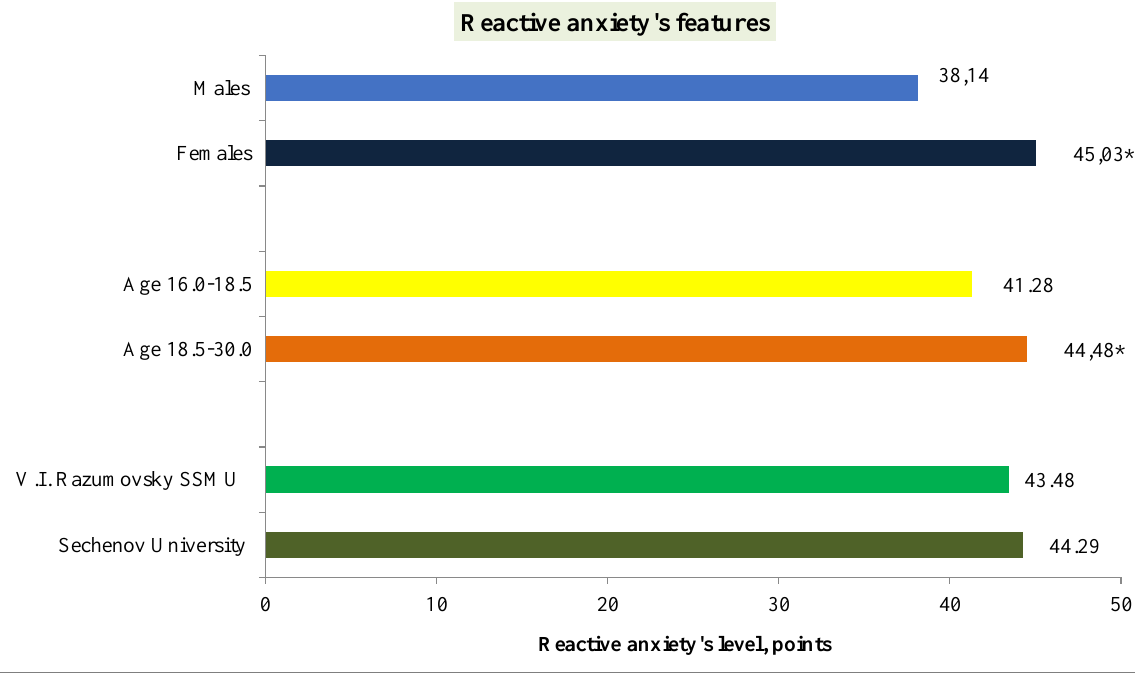
Figure 2. The reactive anxiety's level of medical students depending on gender, age and region. Note: * Significant differences in comparison with the other subgroup, p <0.05. Thus, the state of females in comparison with males was characterized by more intensely felt emotions: tension, anxiety, and nervousness in these specific conditions (45.03 ± 2.19 and 38.14 ± 1.44, respectively, p <0.05). There was a significant increase in the reactive anxiety to the current stressful situation with age (41.28 ± 1.41 and 44.48 ± 1.74, respectively, p